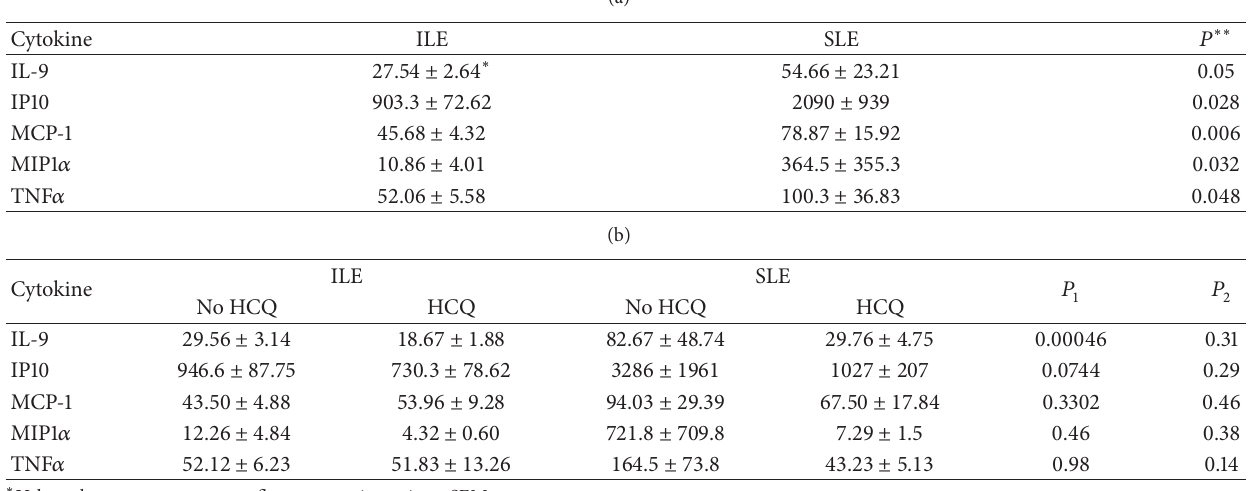
Table 5: Cytokine array results in ILE and SLE